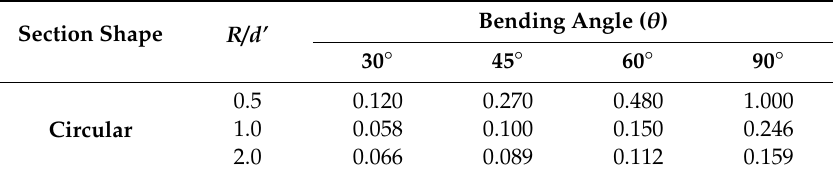
Table 1. The local head loss coe ffi cient of circular bending pipes